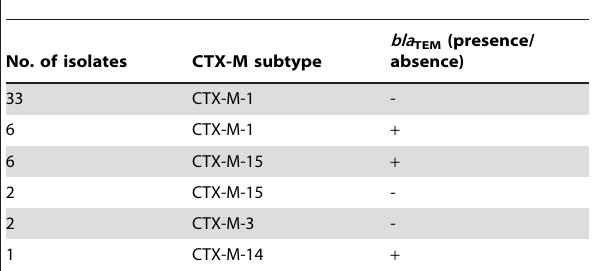
Table 2. CTX-M encoding genes and the presence of bla TEM in the MLST-subset of 50 ESBL-producing isolates from Franklins